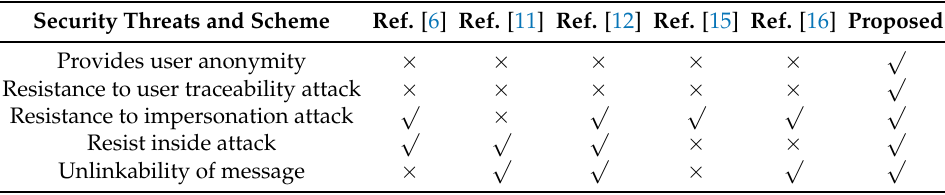
Table 6. Comparison of security